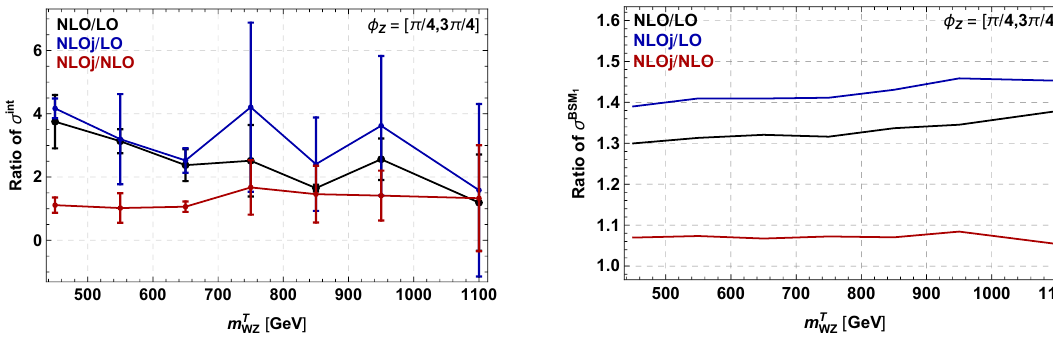
Figure 3 . Di(cid:11)erential distribution for the NLO/LO, NLO+ j /LO and NLO+ j /NLO ratios of (cid:27) int (left panel) and (cid:27) BSM 1 (right panel) in function of the WZ transverse mass.